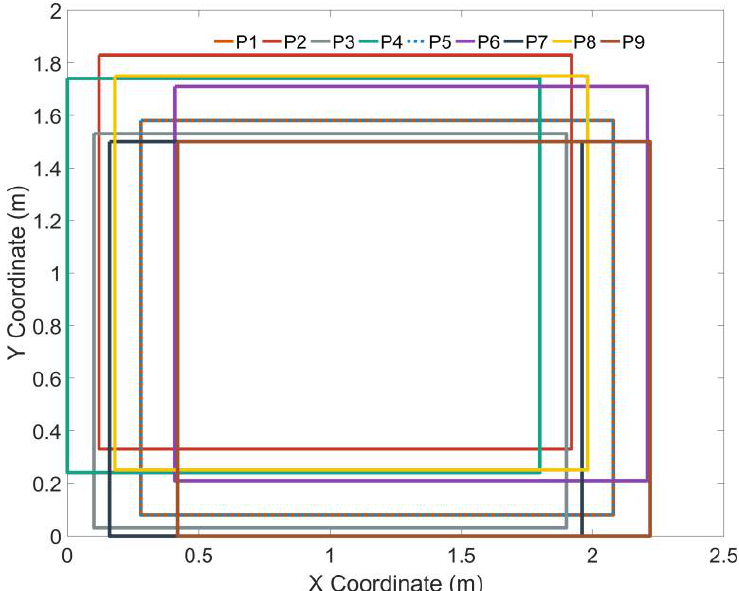
Figure 10. Horizontal position of the target in each of the nine passages (P1–P9). The origin of the relative coordinate system corresponds to the point (6.2241 × 10 5 , 4.8576 × 10 6 ) of the Universal Transverse Mercator (UTM) coordinate system.